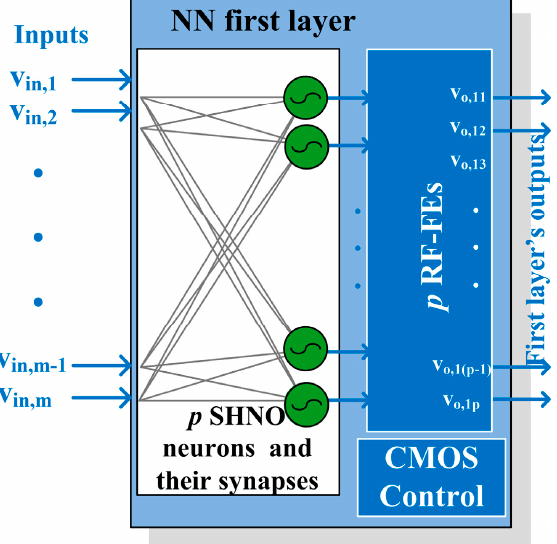
Figure 1. Feed-forward neural network implemented in SHNOs [17] with its p RF-FE blocks.